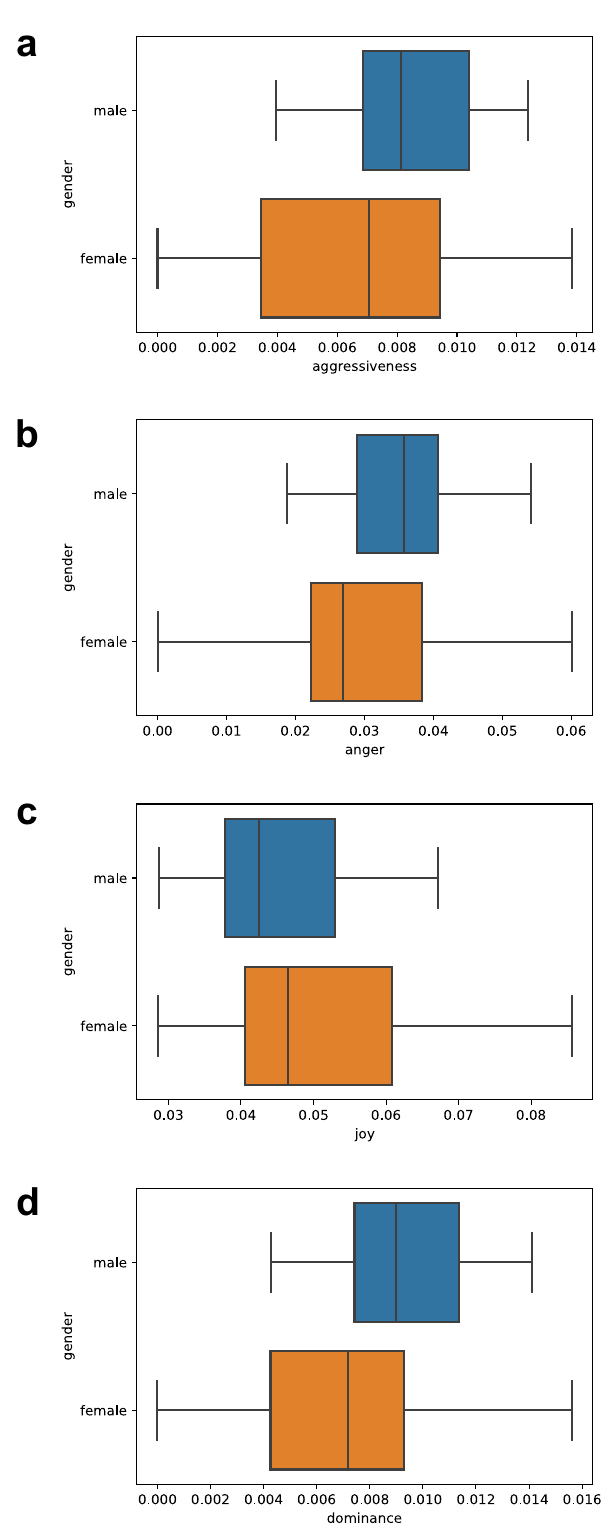
Fig. 7 Box plots on aggressiveness, anger, anxiety, and dominance. a Aggressiveness, b Anger, c Anxiety, d Dominance. values for emotions such as joy. These results are in line with the gender stereotypes in our society. Women are perceived to be more loving and caring, whereas men are supposed to be more aggressive and powerful.